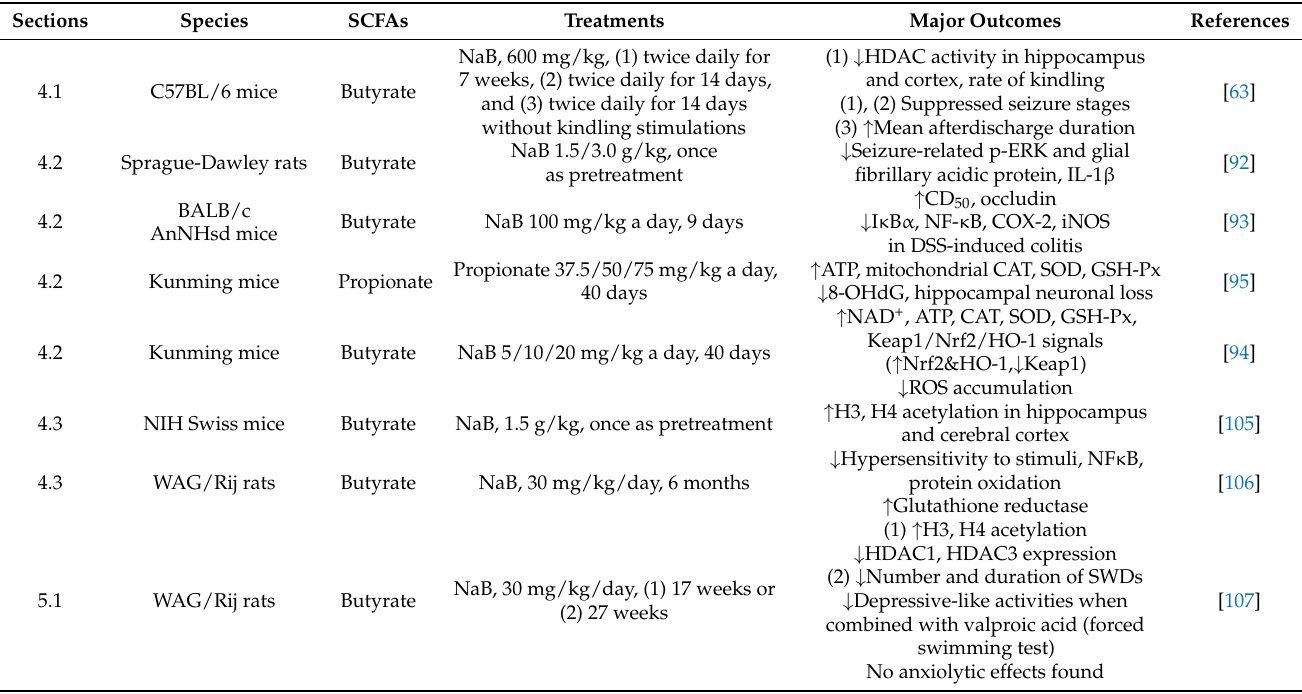
Table 2. The effects of SCFA administration on subjects with